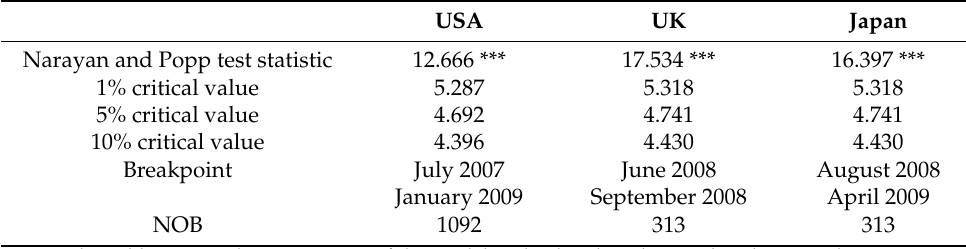
Table 9. Multiple-break unit root tests: Narayan and Popp